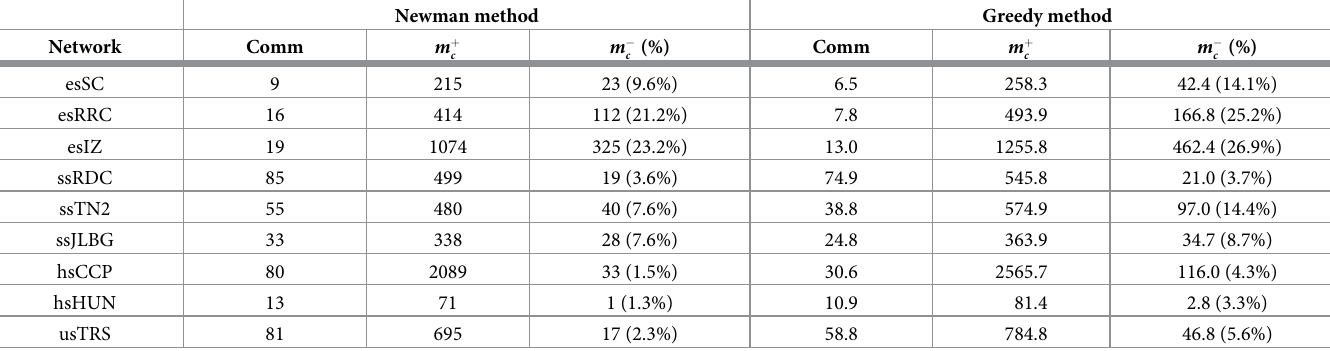
Table 3. Positive and negative links in the signed communities.